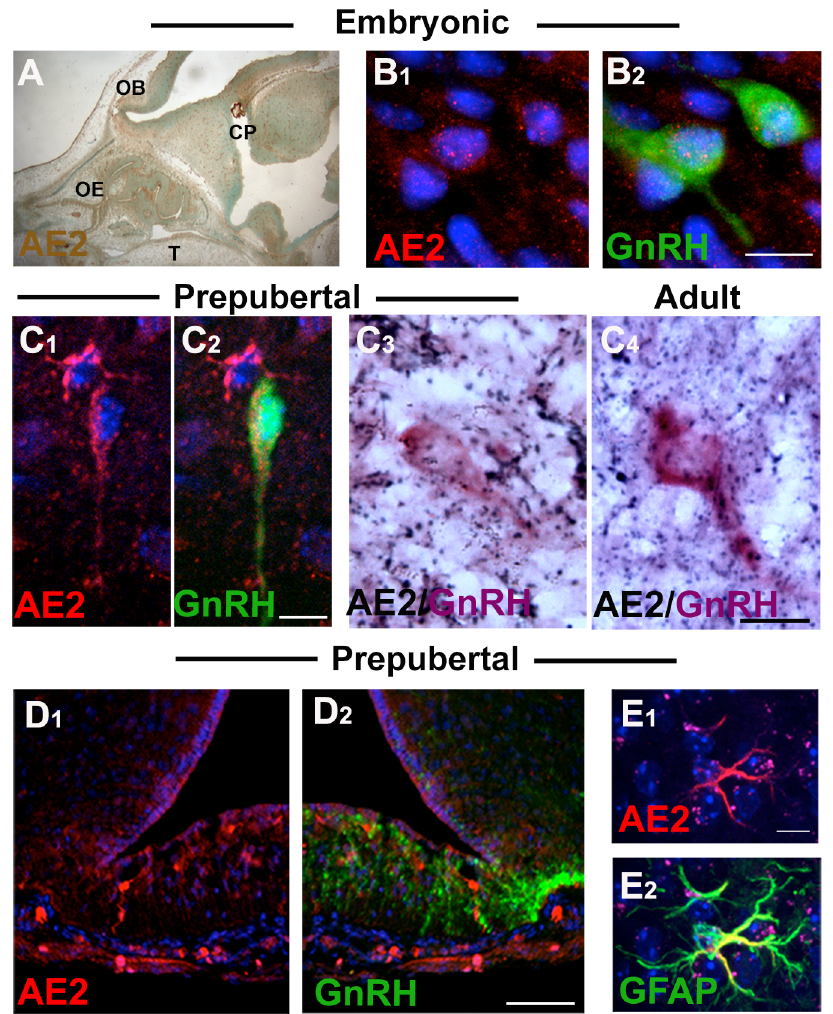
double-labeling for AE2 (NiDAB, black) and GFP (ABC-AP, purple) confirmed that GnRH neurons express AE2 in pre-pubertal (C3) and adult (C4) mice. D) No AE2 (red) expression was detected on GnRH fibers (green) in the median eminence, whereas astrocytes (GFAP, green) in neighboring regions were AE2 positive (E). Scale bars: B, C and E = 10 μ M; D = 100 μ